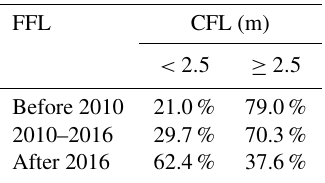
Table 2. Percentage of the area assigned with FFL per three classes of year in each class of CFL based on its relationship with fire in-